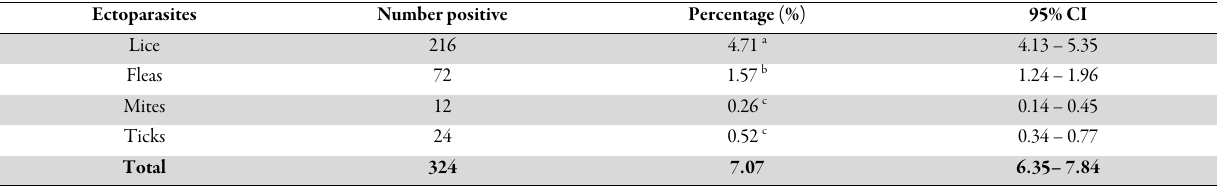
Table 1. Prevalence (%) of ectoparasitic infestations among 4,584 avian species presented in the major Veterinary Hospitals in Osun State from 2006-